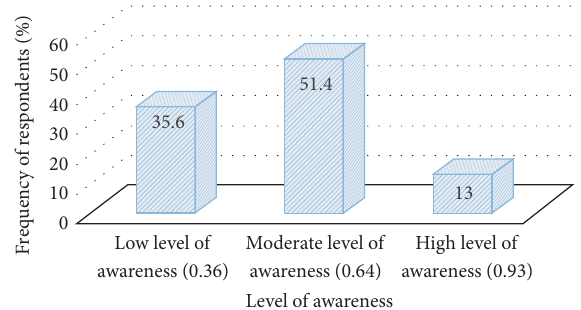
Figure 1: Level of awareness and frequency of respondents. Source: author’s computations from field survey,